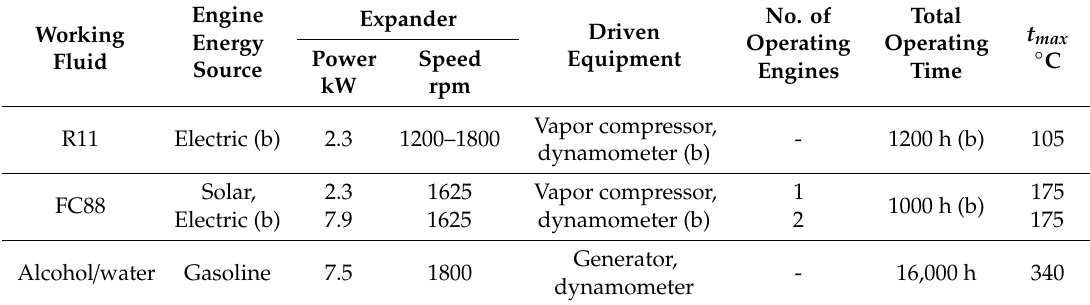
Table 1. Technical data of the multi-vane expanders tested by General Electric in 1977–1979